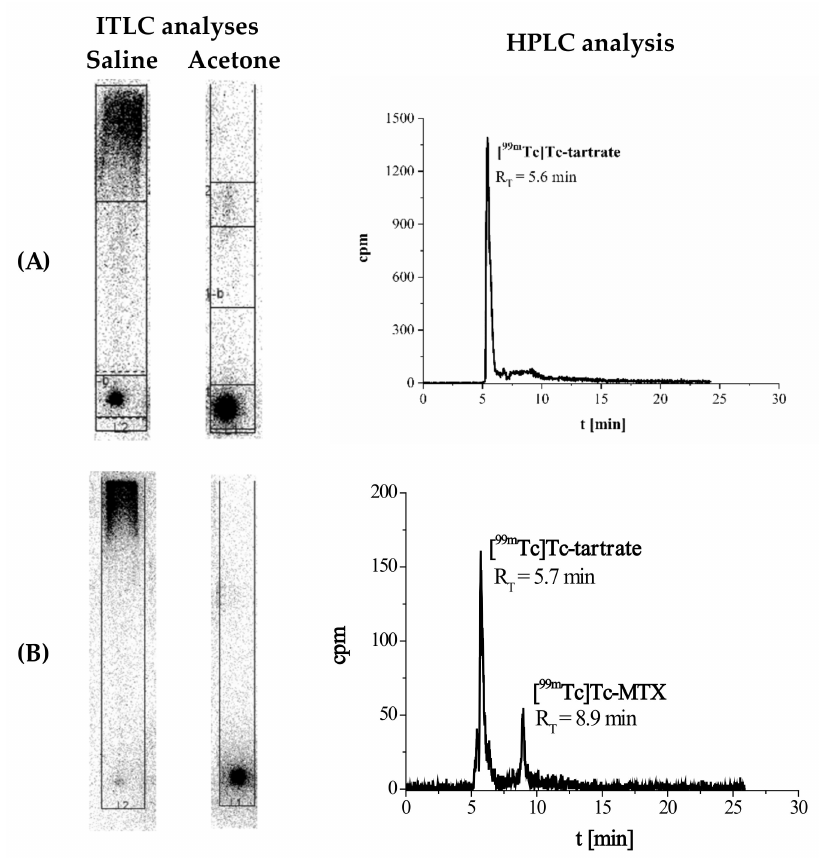
Figure 6. ITLC and HPLC analyses verifying formation of ( A ) intermediate [ 99m Tc]Tc-tartrate complex and ( B ) final [ 99m Tc]Tc-MTX complex. Basing on ITLC results, differentiation between final